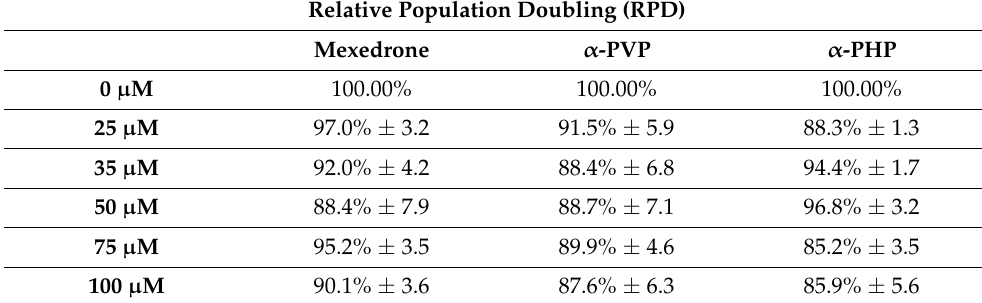
Table 1. RPD on TK6 cells after 26 h treatment with mexedrone, α -PVP, α -PHP at the indicated concentrations compared to the negative control [0 µ M]. Data are presented as mean ± SEM of five independent